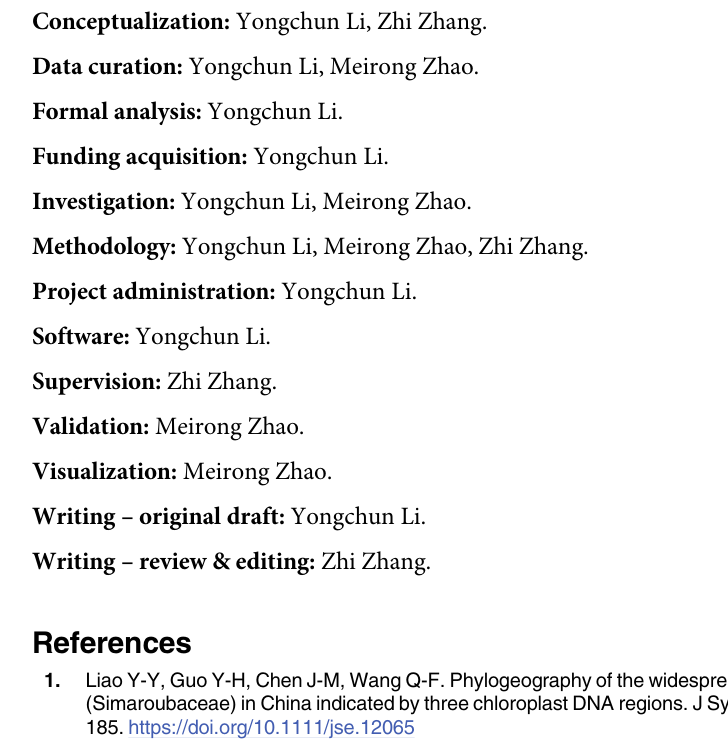
S3 Fig. GO analysis of biological process (a), cellular component (b), and molecular function (c). (TIF) S4 Fig. KEGG pathway enrichment bubble plot of differentially expressed proteins. The vertical axis represents the enriched KEGG classification (fold > 1.5, p < 0.05). The horizontal axis is the rich factor (rich factor � 1), representing the ratio of the number of differentially expressed proteins to those identified in the KEGG pathway. The size of the circular area rep- resents the number of differentially expressed proteins, and the circular color represents the enrichment p-value of the differentially expressed proteins under the KEGG classification. (TIF) S1 Table. Details of 203 differentially expressed proteins. S2 Table. Bioinformatics analysis of differentially expressed proteins. S3 Table. Comparison of PRM analysis with the label-free quantitative proteomics trig- gered by